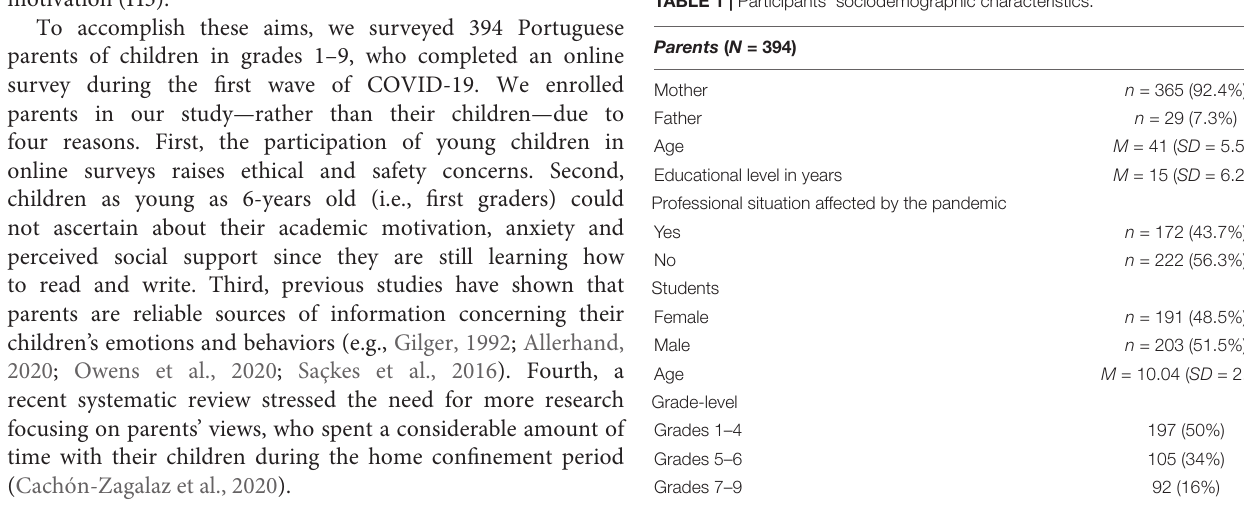
TABLE 1 | Participants’ sociodemographic